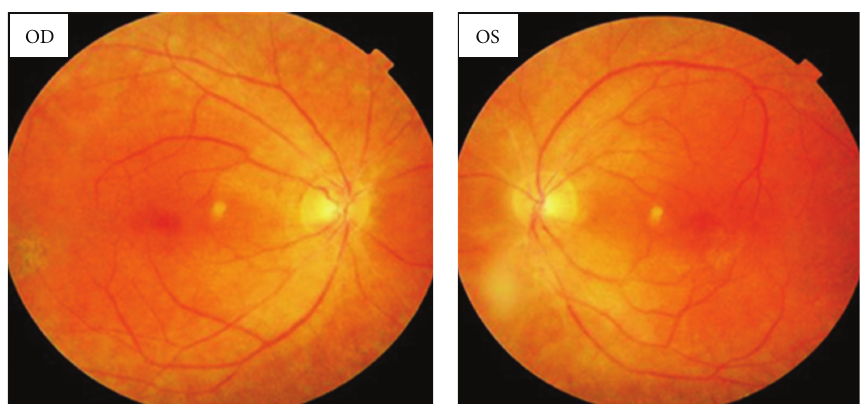
Figure 2: Peripheral and equatorial hyperpigmentation, arteriolar attenuation, pallor of the optic nerve, and